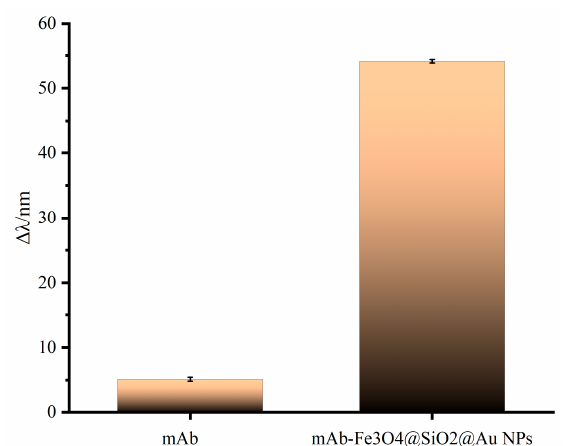
Figure 6. The SPR response of T-2 toxin monoclonal antibody and T-2 toxin monoclonal antibody modified with magnetic Fe 3 O 4 @SiO 2 @Au NPs.